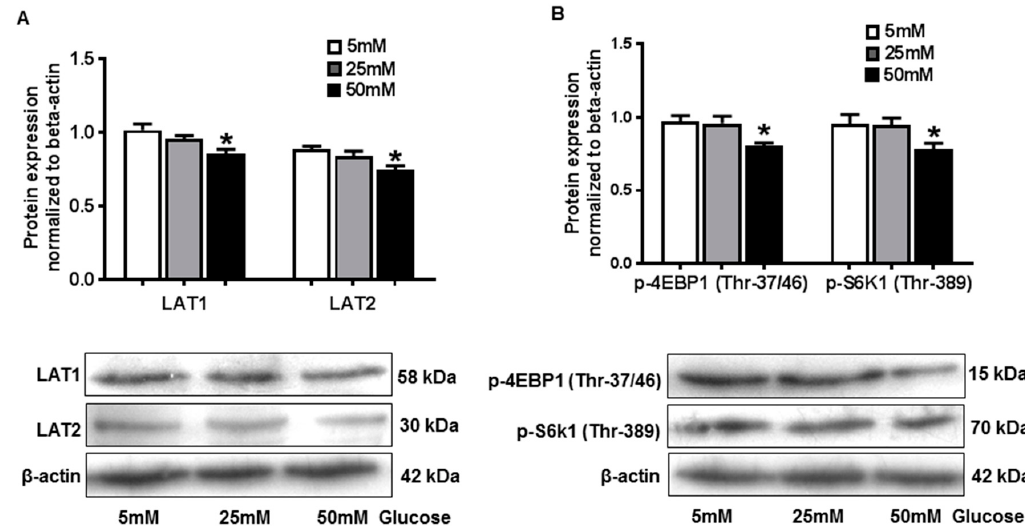
Figure 4. High glucose in vitro down-regulated amino acid transporter expression and mTORC1 activity in JEG-3 trophoblast cells. ( A ) Protein expression of LAT1 and LAT2 detected by Western blot in JEG-3 trophoblast cells cultured with di ff erent concentration of glucose. The bar graphs show relative expression after being normalized with β -actin expression in each sample. We found that 50mM glucose induced a significant decrease in LAT1 and LAT2 expression. The lower panel shows representative blots for LAT1 and LAT2. * p < 0.05, 5mM versus 50mM. Data are from five independent experiments. ( B ) Protein expression of p-4EBP1 and p-S6K1 detected by Western blot in JEG-3 trophoblast cells cultured with di ff erent concentration of glucose. The bar graphs show relative expression after being normalized with β -actin expression in each sample. We found that 50 mM glucose induced a significant decrease in p-4EBP1 and p-S6K1 expression. The lower panel shows representative blots for p-4EBP1 and p-S6K1. * p < 0.05, 5 mM versus 50 mM. Data are from five independent experiments.